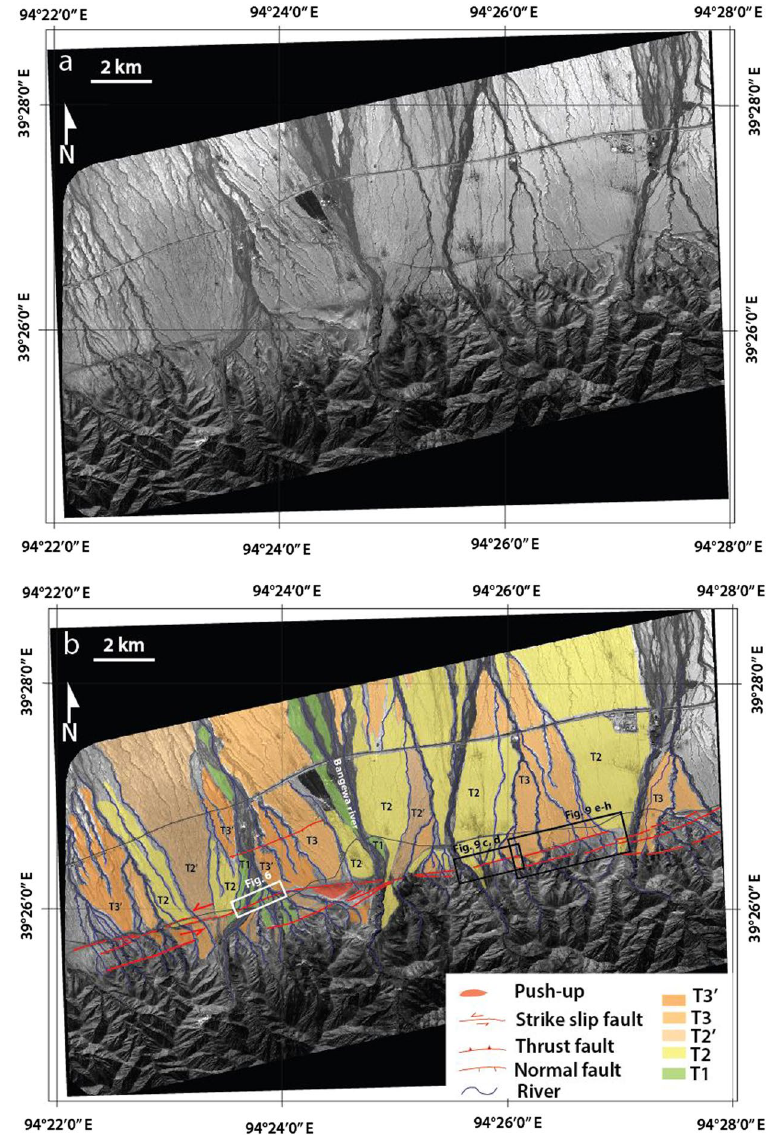
Figure 3. ( a ) Pleiades satellite image (0.7 m resolution) of fans along the ATF near Bangewa. ( b ) Geomorphic interpretation of faulting across the fan apexes and river channels along the fault (revised after Meriaux et al . 16 ). White boxes indicate the locations of Fig. 6. Black boxes indicate the location of Fig. 9c,d and